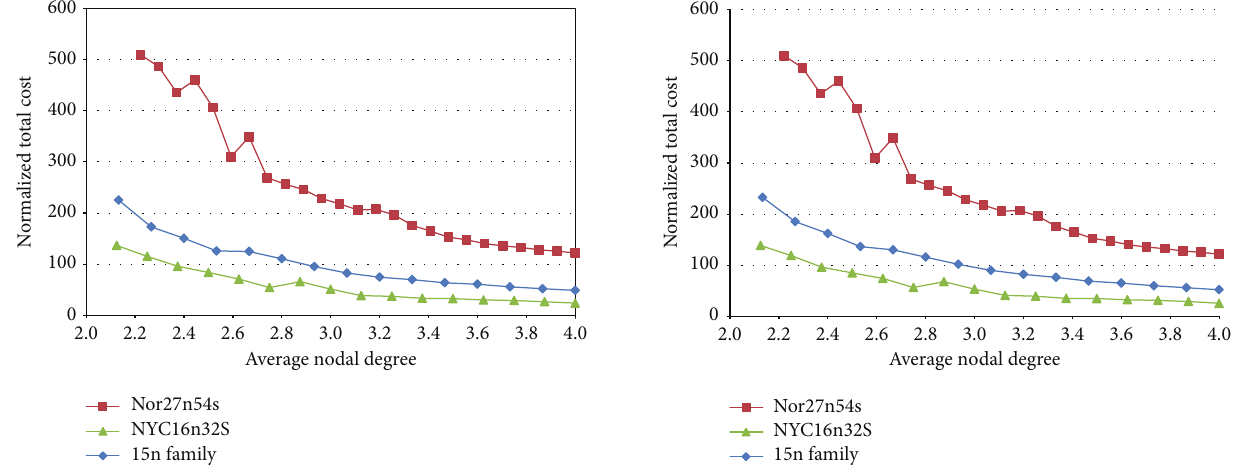
Figure 27: Normalized SBPP restoration JCA costs for network families based on real network.